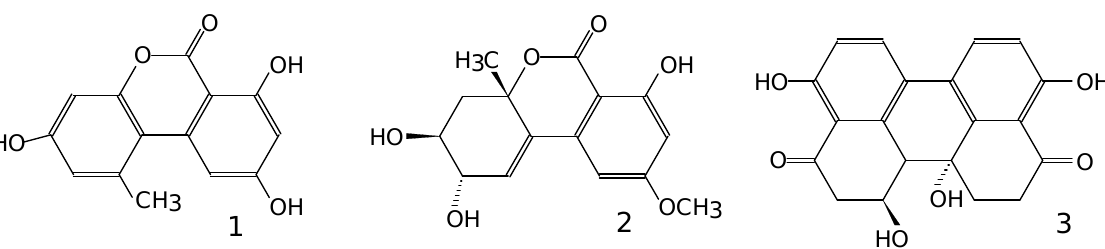
(1), moniliformin (usually as 1